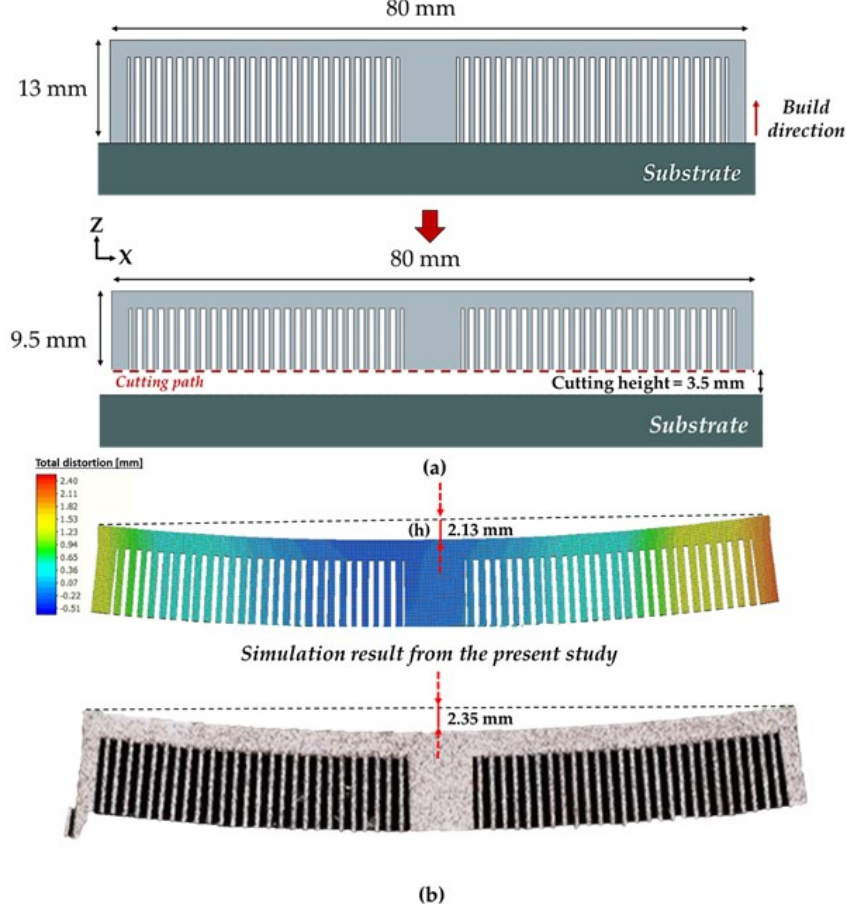
Figure 6. ( a ) The twin-cantilever beam with cutting path; ( b ) the comparison of the twin-cantilever beam distortion between simulation result obtained from the present study and the experimental study from Siewert et al. (experiment measurement modified from Siewert et al. [47]. Reproduced with license 5362460533296. Copyright 2022 Elsevier. (h) is the distance of the part's middle point on the surface to a line.